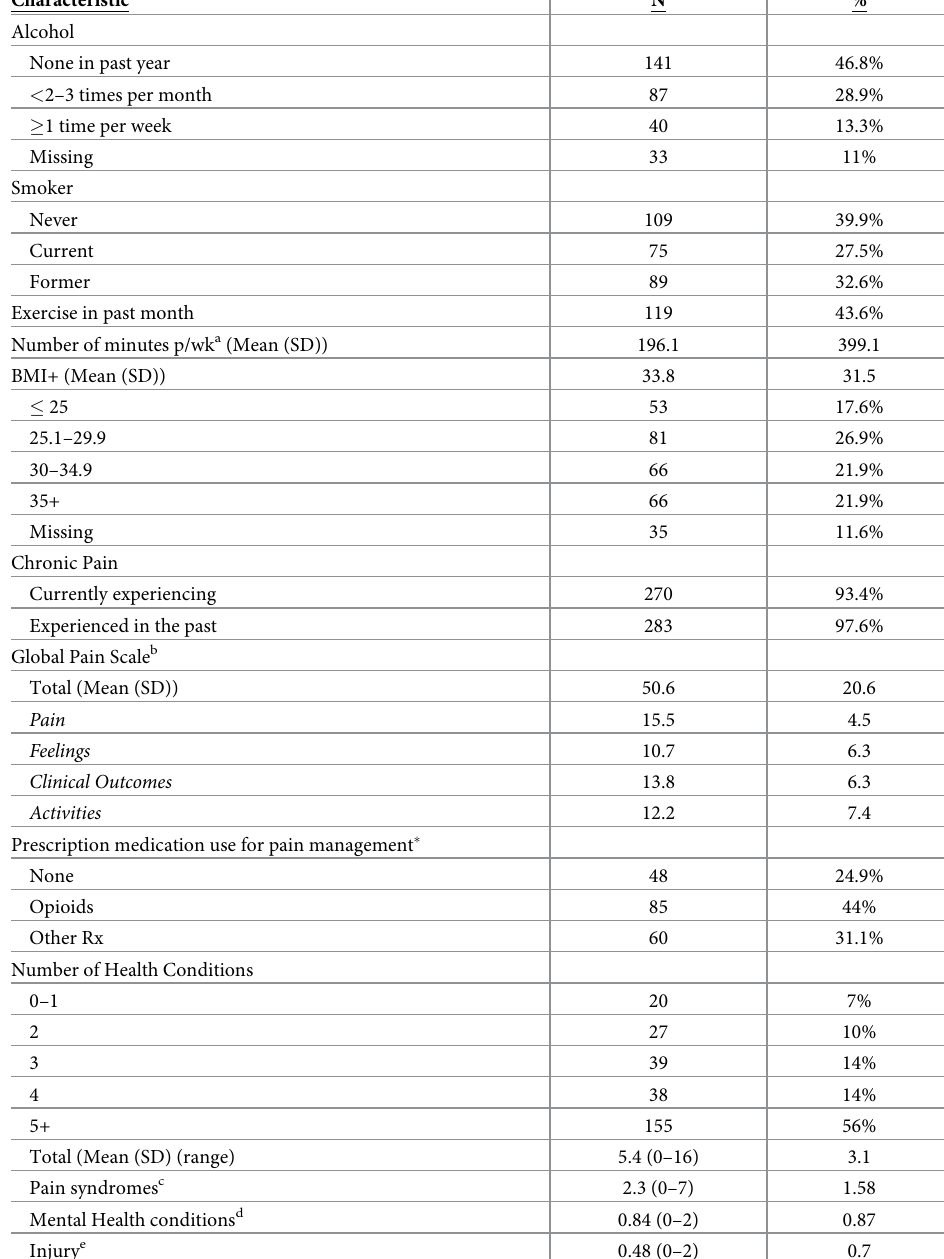
Table 3. Lifestyle and Health characteristics of Appalachian pain patients, Complementary Health Approaches for Pain Survey (CHAPS), WV, 2014–2016.